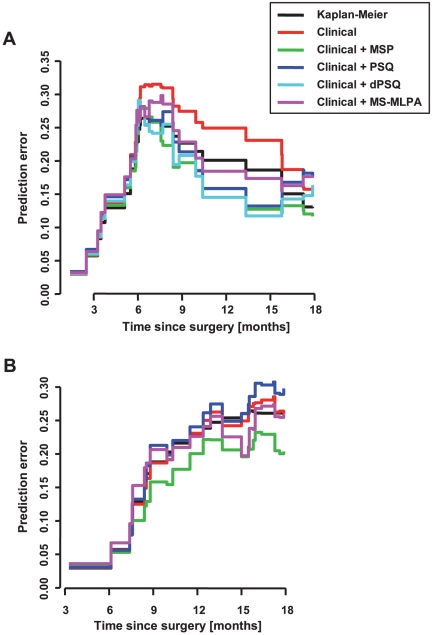
Prediction error curves for each diagnostic method with respect to (A) PFS and (B) OS.To assess the predictive accuracy of models including methylation data, the cumulating prediction error curves over 18 months follow-up time and a time-dependent R2-like measure were computed for the marginal Kaplan-Meier estimates (Kaplan-Meier), the Cox model using clinical data only (i.e., age, gender, Karnofsky performance status, extent of resection [Clinical]), and the Cox model using combined clinical plus methylation data as determined by MSP (Clinical + MSP), PSQ CpG sites 1 to 5 (Clinical + PSQ), dichotomised PSQ CpG sites 1 to 5 (Clinical + dPSQ), and MS-MLPA sites 1 to 3 (Clinical + MS-MLPA). Prediction error curves for dichotomised methylation data at MS-MLPA sites 1 to 3 (PFS and OS) and pyrosequencing CpG sites 1 to 5 (OS) were not feasible due to insignificant cut-points (see Table 2).